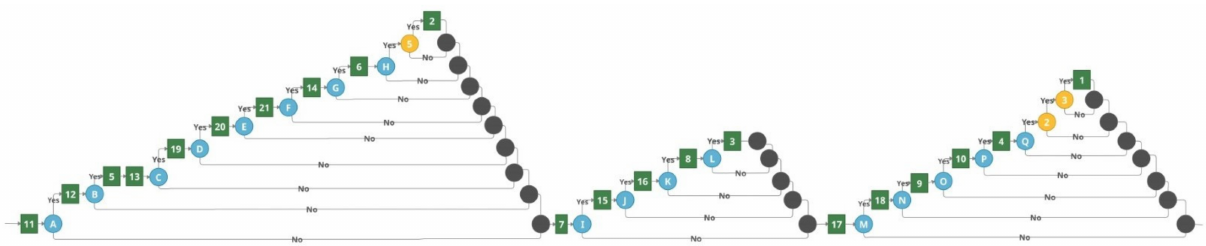
Figure 7. Result of BTCG transformation for the competence tree, presented in Figure 3 when all competencies except 2nd level competencies 2, 3, and 4 are sequentially